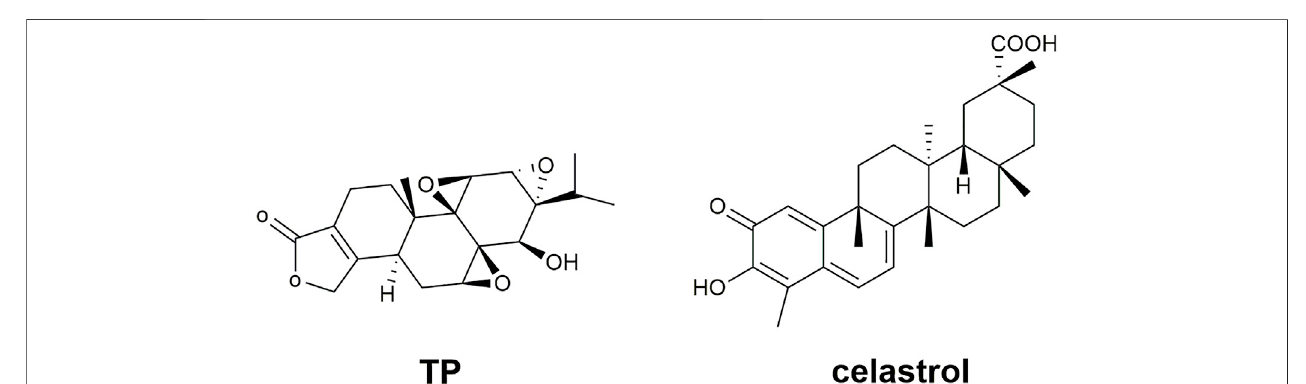
FIGURE 2 | The structural formulas of TP and